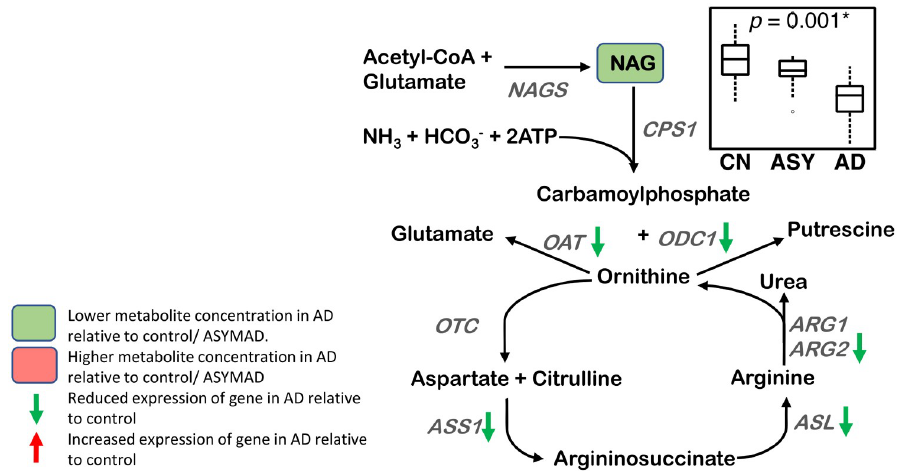
Fig 7. Urea cycle. A lower concentration of NAG is observed in AD in the ITG. The genes ARG2, ASL, ASS1, OAT, and ODC1 have reduced expression in the hippocampus/ERC in AD compared to CN. Sample size: AD = 17, ASY = 13, CN = 13; p -values indicate significance after FDR correction for multiple comparisons. An asterisk ( � ) indicates metabolite was also significant after Bonferroni correction. AD, Alzheimer disease; ARG1, arginase 1; ARG2, arginase 2; ASL, argininosuccinate lyase; ASS, argininosuccinate synthase; ASY, asymptomatic AD; CN, Control; CPS1, carbamoyl phosphate synthetase I; ERC, entorhinal cortex; FDR, false discovery rate; ITG, inferior temporal gyrus; NAGS, N-acetylglutamate synthase; OAT, ornithine aminotransferase; ODC1, ornithine decarboxylase 1; OTC, ornithine transcarbamylase; NAG, N-acetyl glutamate.